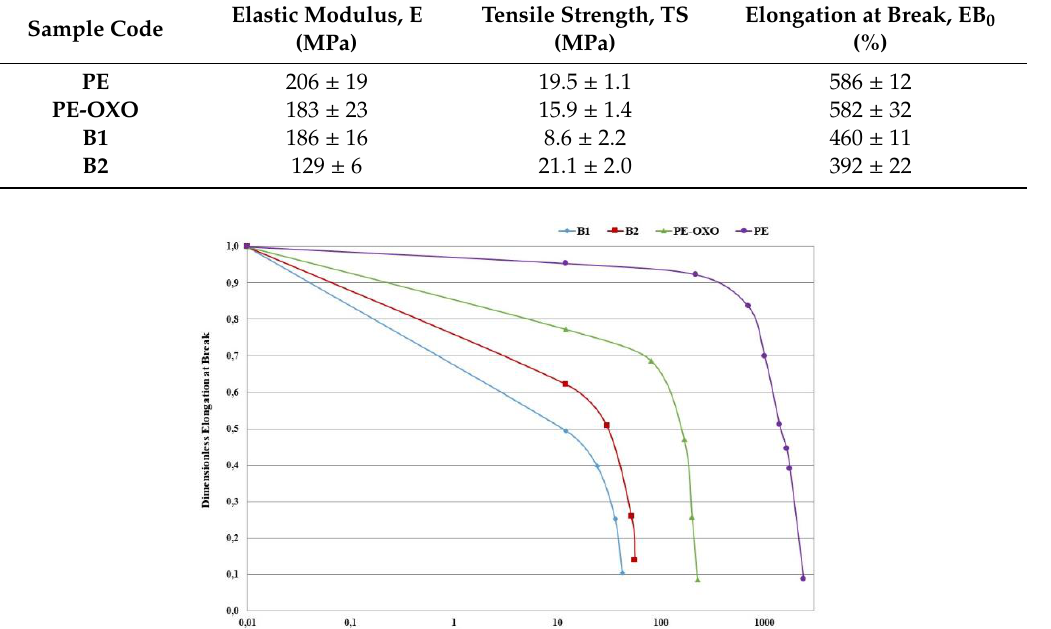
Figure 1. Dimensionless elongation at break vs. photo-oxidation time of all the samples.